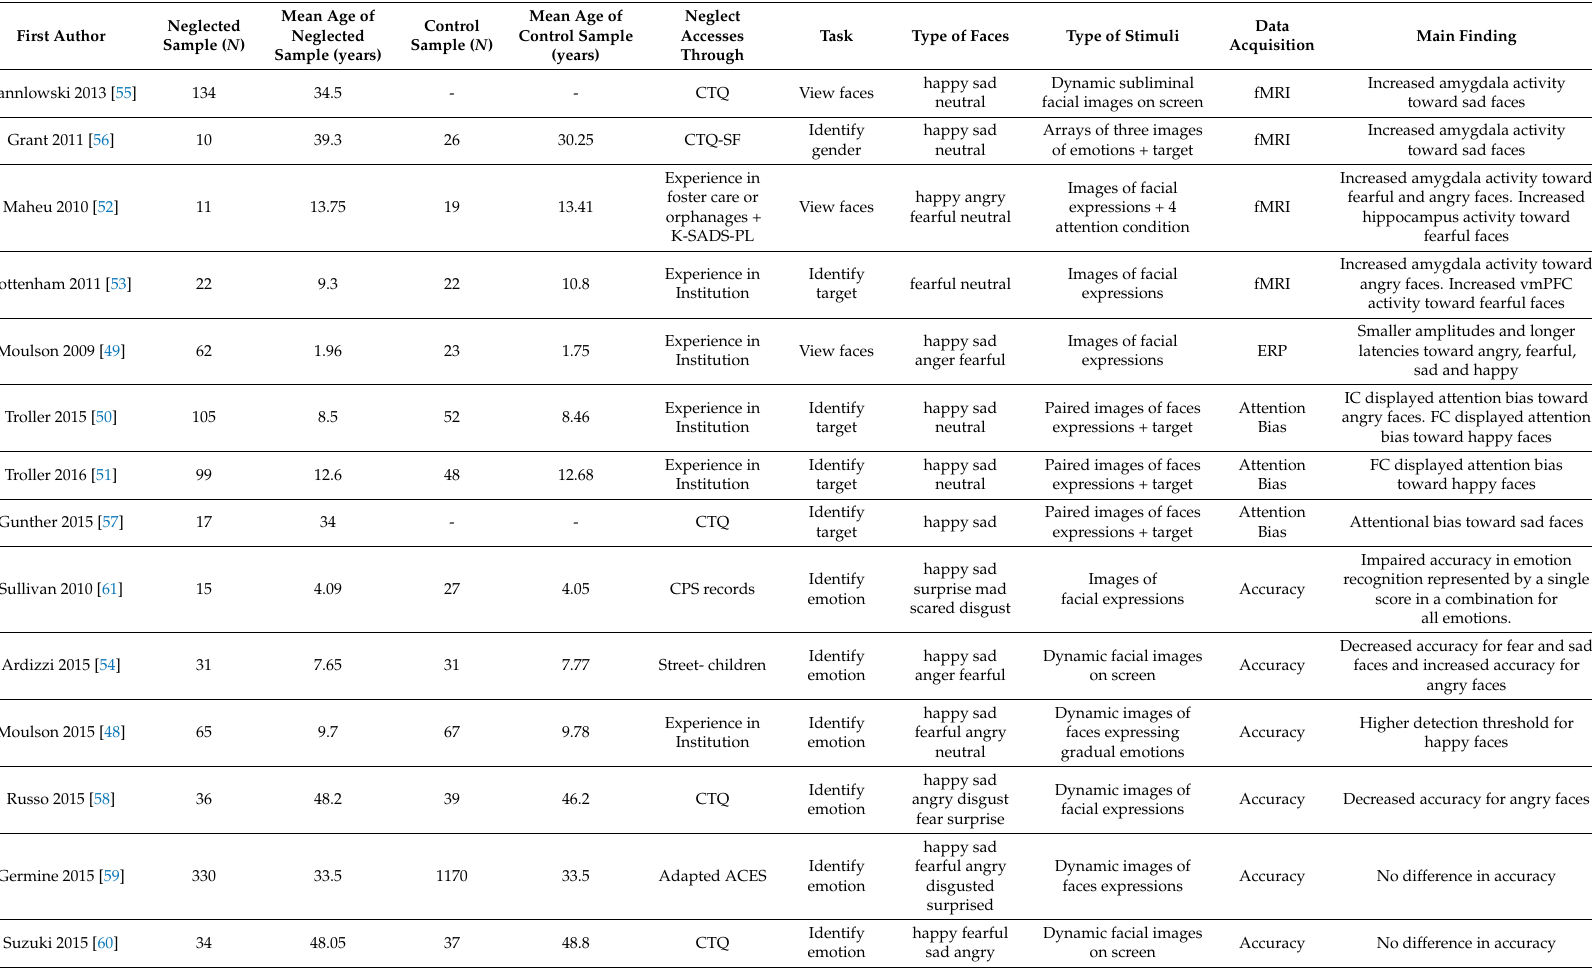
Table 1. Characteristics and main findings of the studies of child negligence and its impact on emotional recognition and